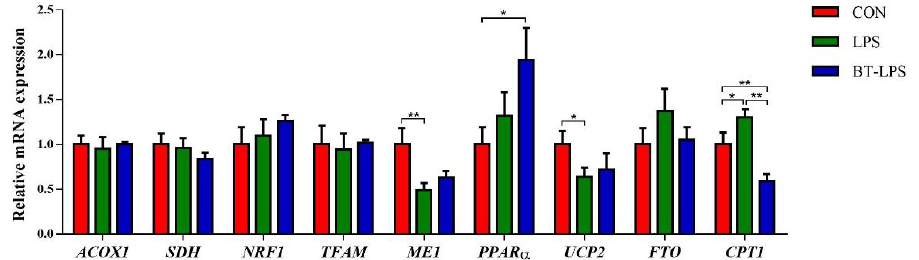
Figure 7. The effects of butyrate on energy metabolism relative gene mRNA levels in LPS-induced jejunum. Values are the mean ± standard error ( n = 6). * p < 0.05 and ** p < 0.01.